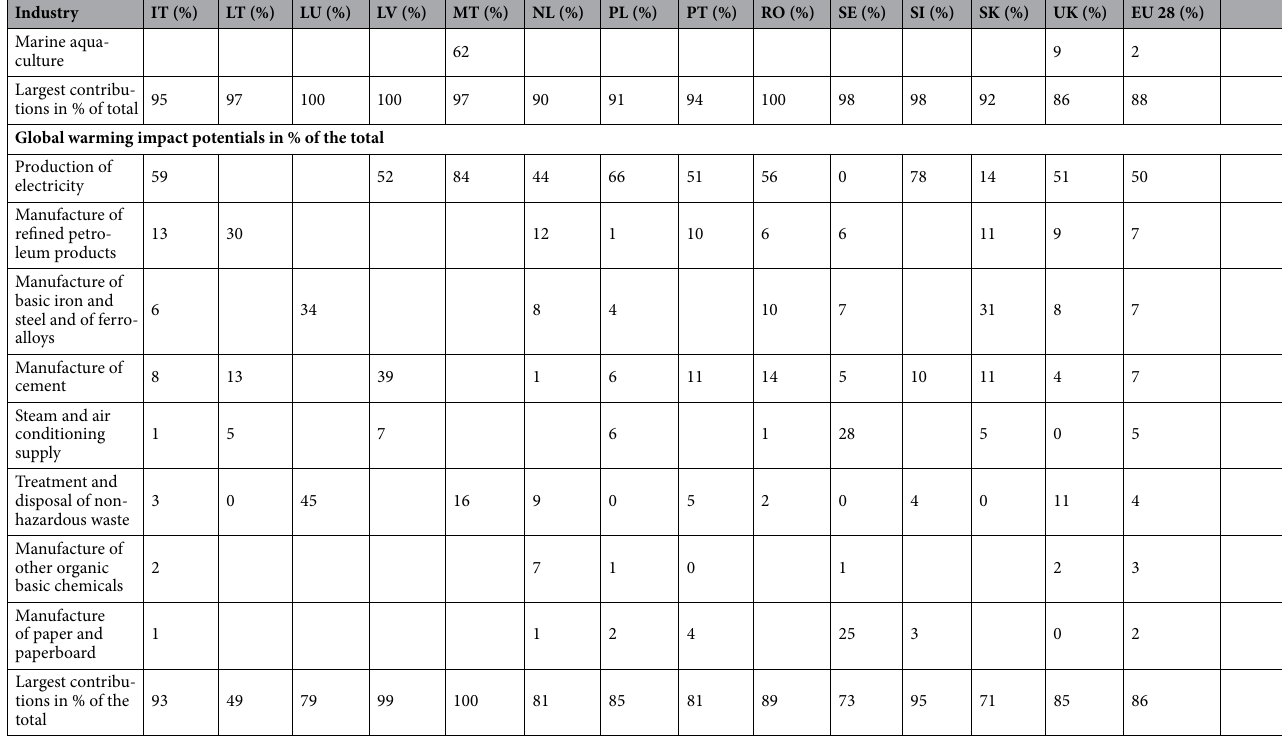
Table 3. Human toxicity, ecotoxicity and climate change impact potentials by NACE sectors (2017, % based on CTUh, CTUe and CO2